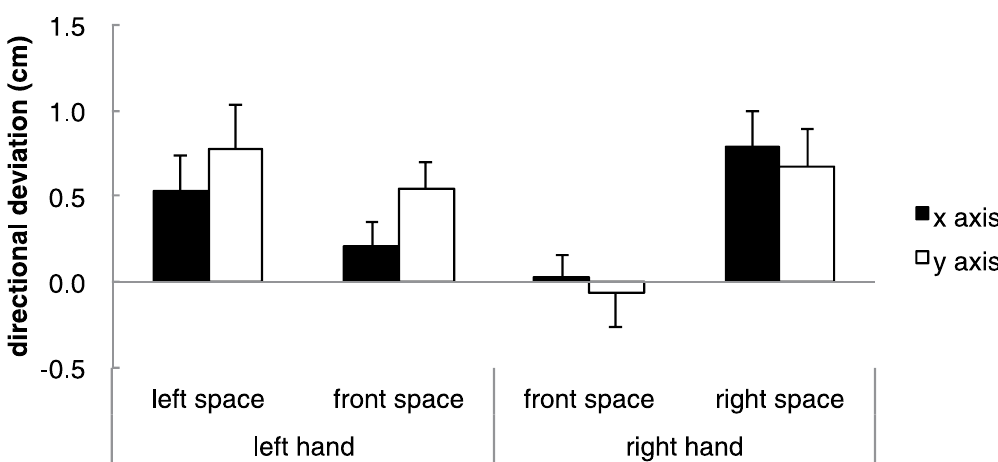
Fig 6. Mean directional deviations for each axis in each space for the left hand and right hand. Error bars show SE .